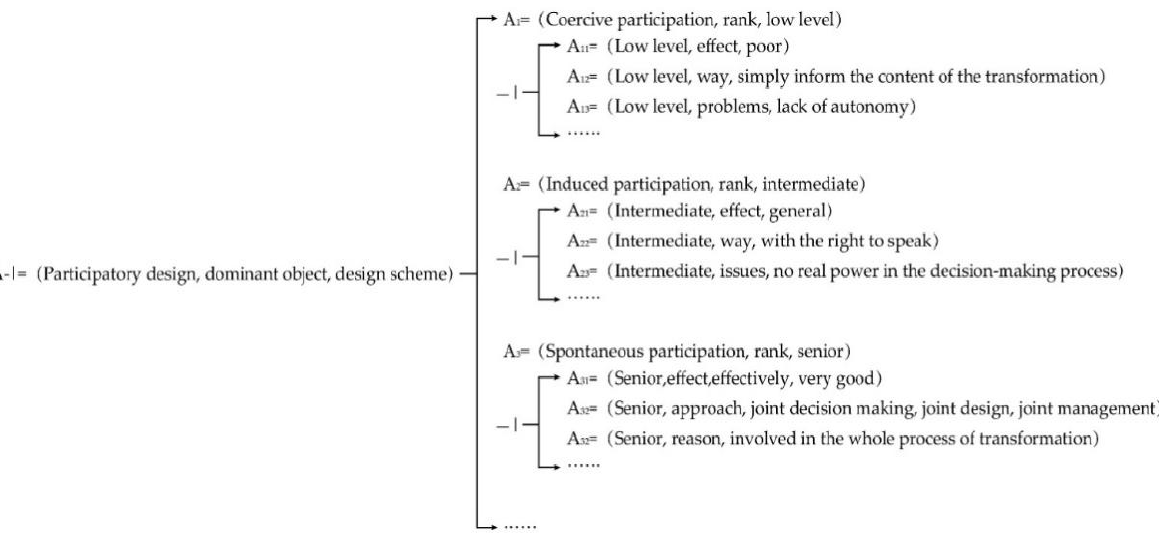
Figure 9. The divergent tree of the participatory design.